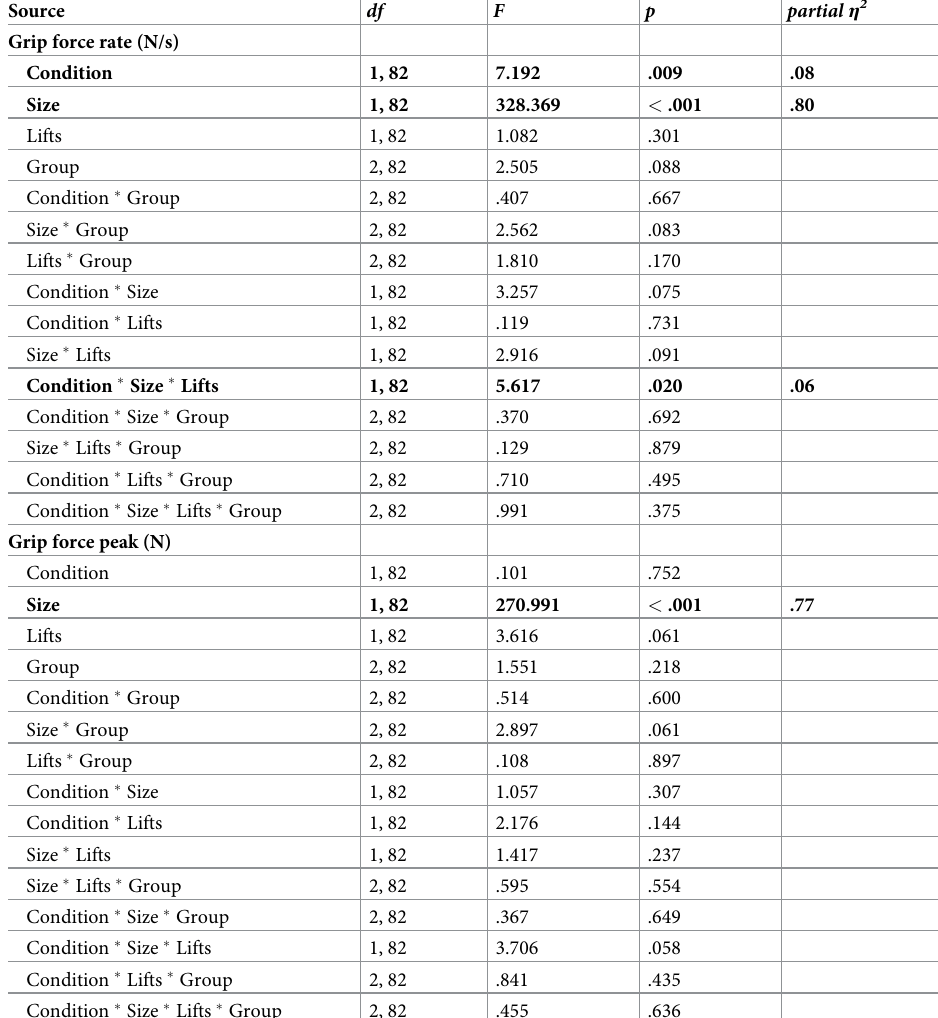
Table 3. Results of two mixed measures ANOVA for grip force peak rate (N/s) and grip force peak (N). Source df